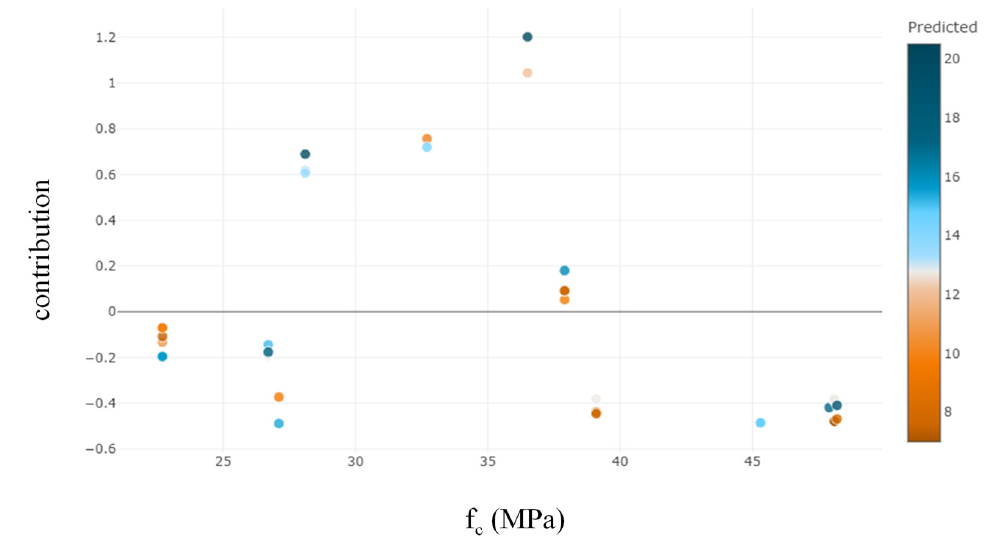
(cid:48) towards the target Figure 9. Feature contribution of f c ′ towards the target variable. Figure 9. Feature contribution of f c